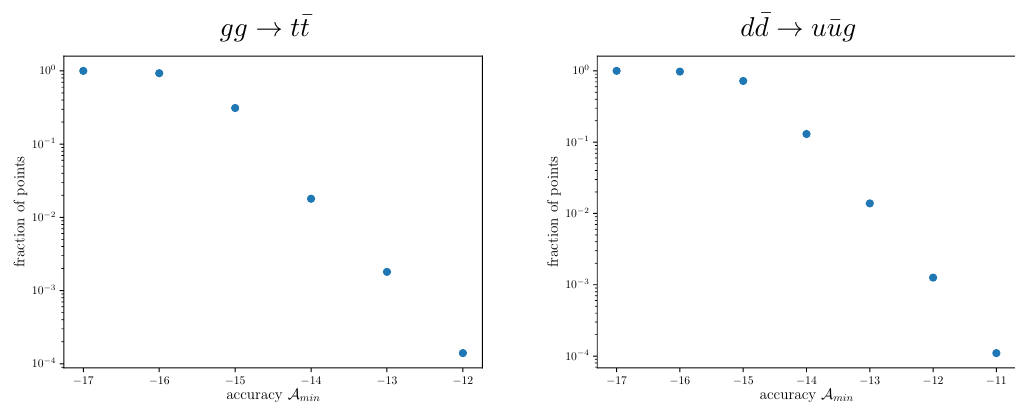
Figure 5 . Numerical stability of the two-loop algorithm for irreducible diagrams in pseudotree mode. The plots show the fraction of phase-space points with a double-precision instability A DP > A min as a function of A min . The distributions correspond to gg → t ¯ t (left) and d ¯ d → u ¯ ug (right) samples with 10 5